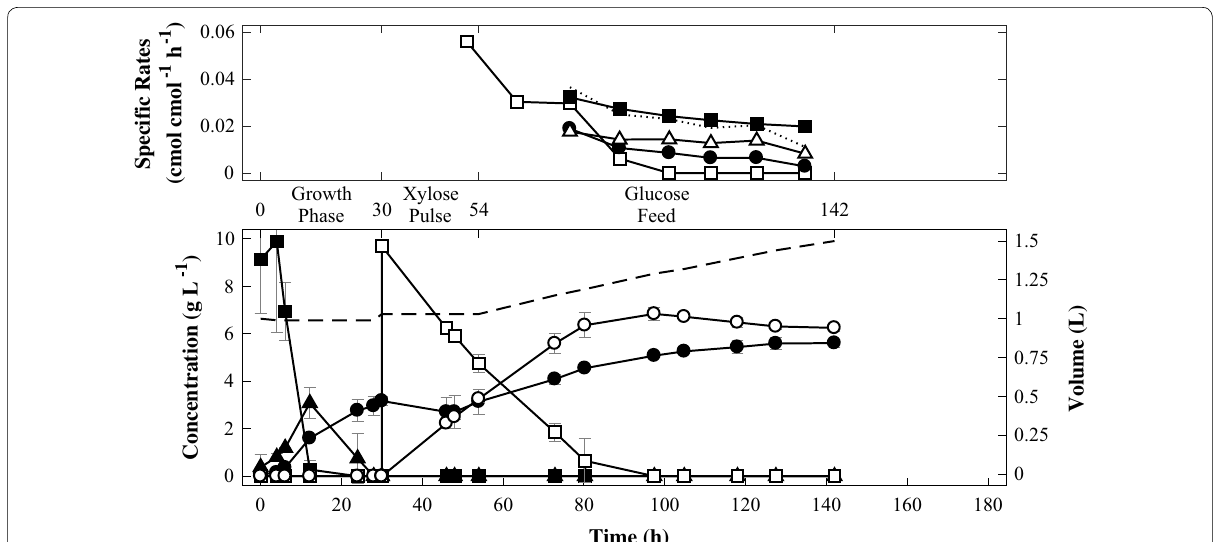
Fig. 4 Fed‑batch experiments with strain TMB4531 ( xylB , xad_Hv , xylX , xylA ). d ‑Glucose (filled square), biomass (filled circle), ethanol (filled triangle), d ‑xylose (square), d ‑xylonate (circle), CO 2 (triangle) and liquid volume (straight line). The dotted line represents the sum of specific productivity of biomass and CO 2 . All experiments were performed in biological duplicates and standard deviations are indicated with error